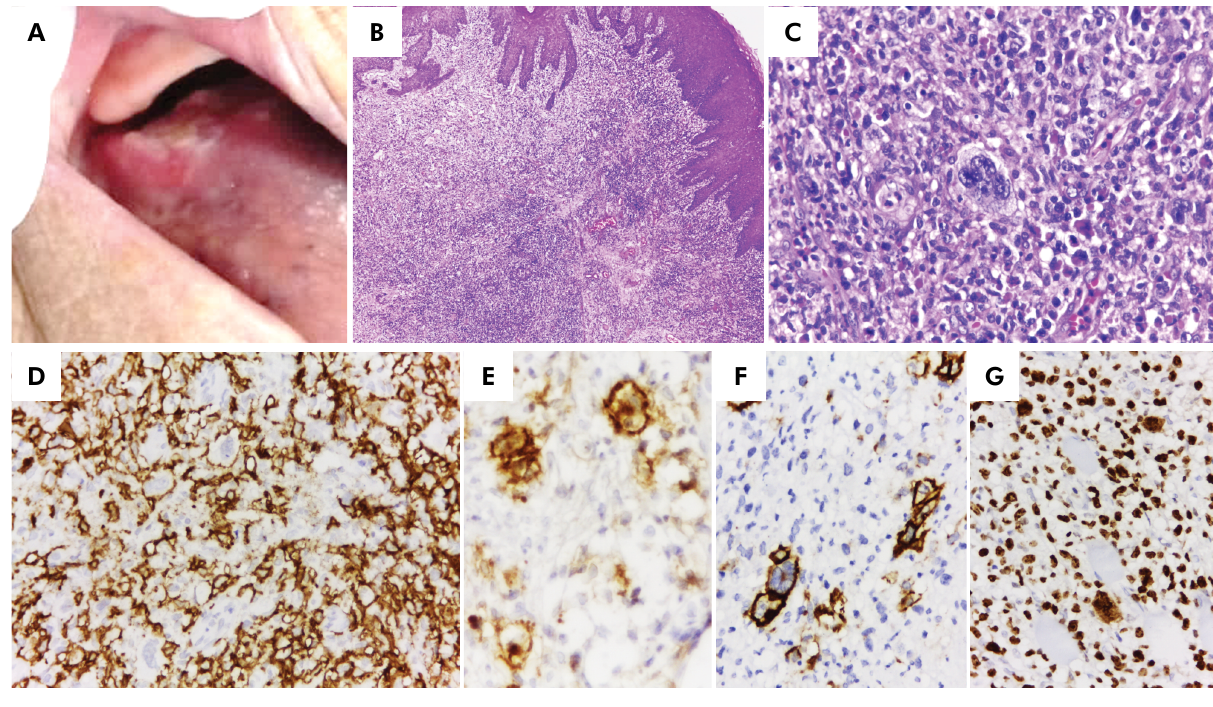
Figure 3. The communication between clinician and pathologist contributing to the diagnosis of an EBV-positive mucocutaneous ulcer. 3A. The lesion was an extremely painful ulcer on the posterior dorsum of the tongue of an 89-year-old female, who was submitted for an incisional biopsy. 3B. Microscopically, pseudoepitheliomatous hyperplasia of the intact epithelium adjacent to the ulcer was observed, covering the connective tissue, containing a dense proliferation of polymorphic infiltrate with angioinvasion and necrosis (hematoxylin-eosin, 100x). 3C. There was a variable number of plasma cells, histiocytes, eosinophils, and some Reed- Sternberg-like cells (hematoxylin-eosin, 400x). Under suspicion of a large B cell lymphoma, the patient was immediately referred to the hematology service for initial investigation during immunohistochemical reactions. The clinical check-up ruled out systemic disease and nutritional support was offered for the patient. 3D. The immunohistochemical analysis revealed strongly positivity for CD20 (immunohistochemistry, 100x), while Hodgkin-like cells were positive for 3E. CD30 (immunohistochemistry, 400x) and 3F. LMP-1 (immunohistochemistry, 400x). 3G. The Ki-67 proliferative index was 90% (immunohistochemistry, 100x). Two weeks after the incisional biopsy the clinician observed a significant reduction in size of the oral ulcer, and improvement of overall health status of the patient, which contributed to establishing a diagnosis through clinicopathologic correlation. The patient underwent continuous follow-up until the complete healing of the ulcer two months